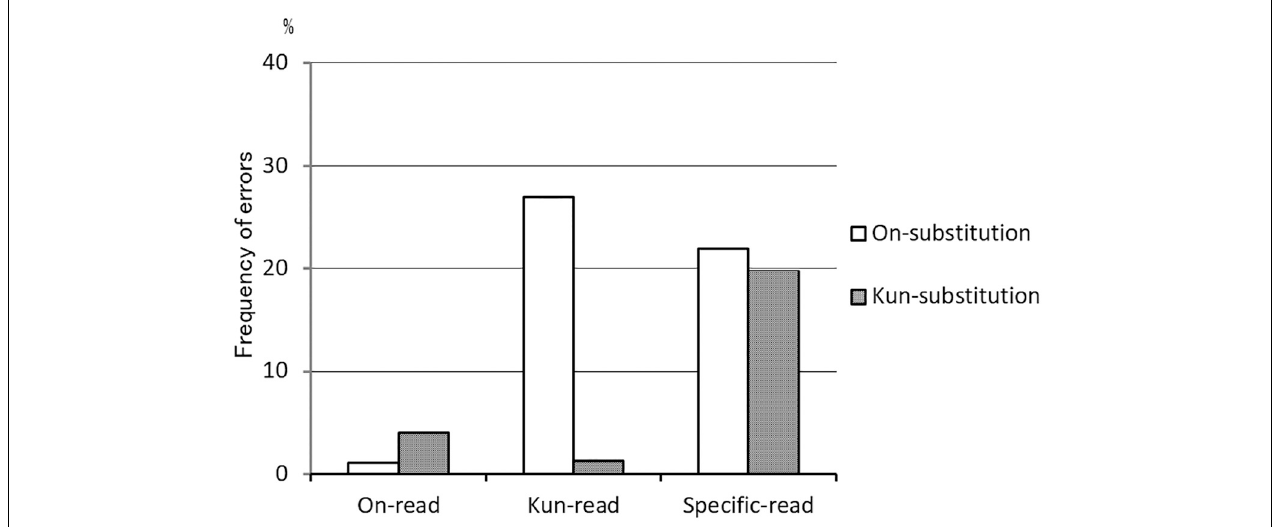
FIGURE 4 | Frequency of substitution errors in the on - kun reading test. On -substitution errors in kun -reading words (27.0%) were more frequent than kun -substitution errors in on -reading words (4.0%) ( p = 0.018 by Wilcoxon signed rank test). In specific-reading words, on - and kun -substitution errors were nearly equal in number ( n = 7). On -reading words = 100 words, Kun -reading words = 100 words, and Specific-reading words = 60